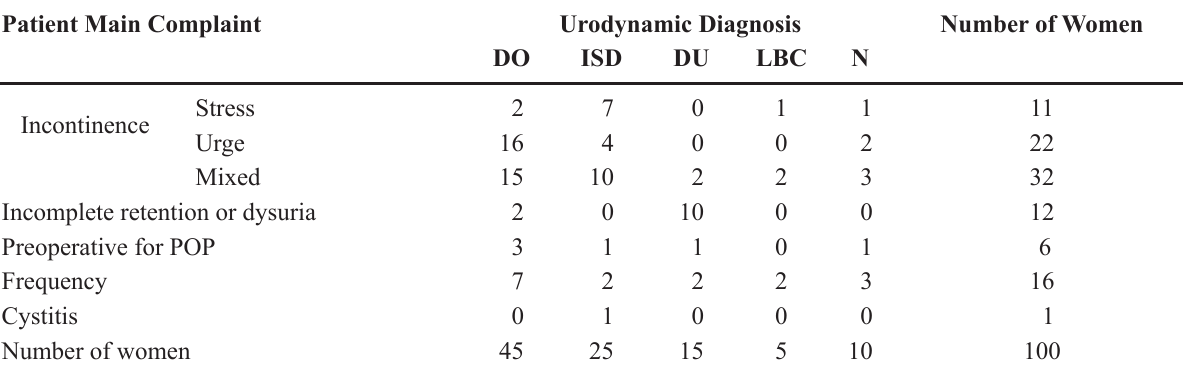
Table 1 – Patient main complaint vs. urodynamic diagnosis. Patient Main